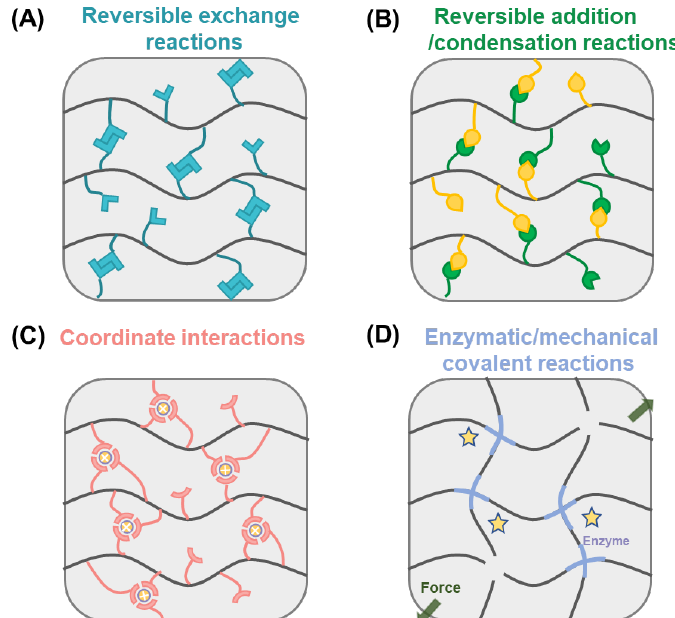
Figure 2. Schematics of dynamic covalent chemistry for hydrogels. ( A ) reversible exchange reac- tions, including disulfide, diselenide, and thioester; ( B ) reversible addition/condensation reactions, such as imine, hydrozone, oxime, and boronic ester; ( C ) coordinate interactions and ( D ) enzy- matic/mechanical covalent reactions.